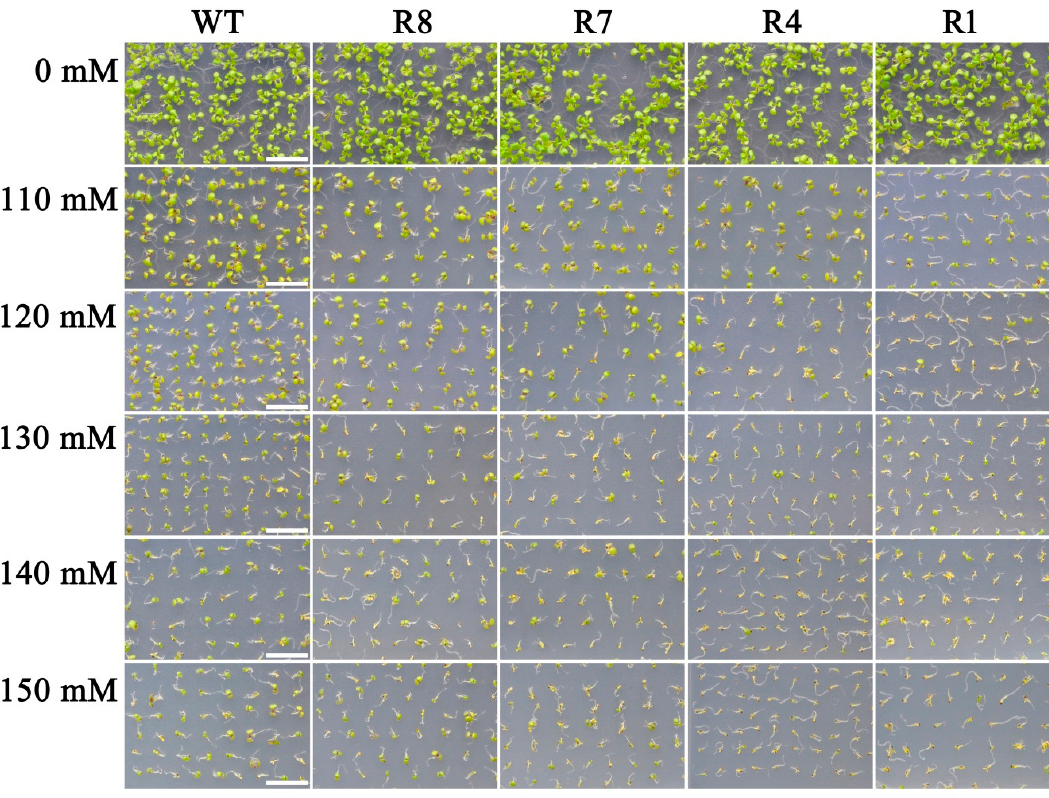
Figure 2. Down-regulation of CPK12 results in NaCl-hypersensitive seedling growth. Seeds were planted in NaCl-free (0 mM) medium or media containing 110, 120, 130, 140, or 150 mM NaCl, and seedling growth was investigated 10 days after stratification. Scale bars, 1 cm.